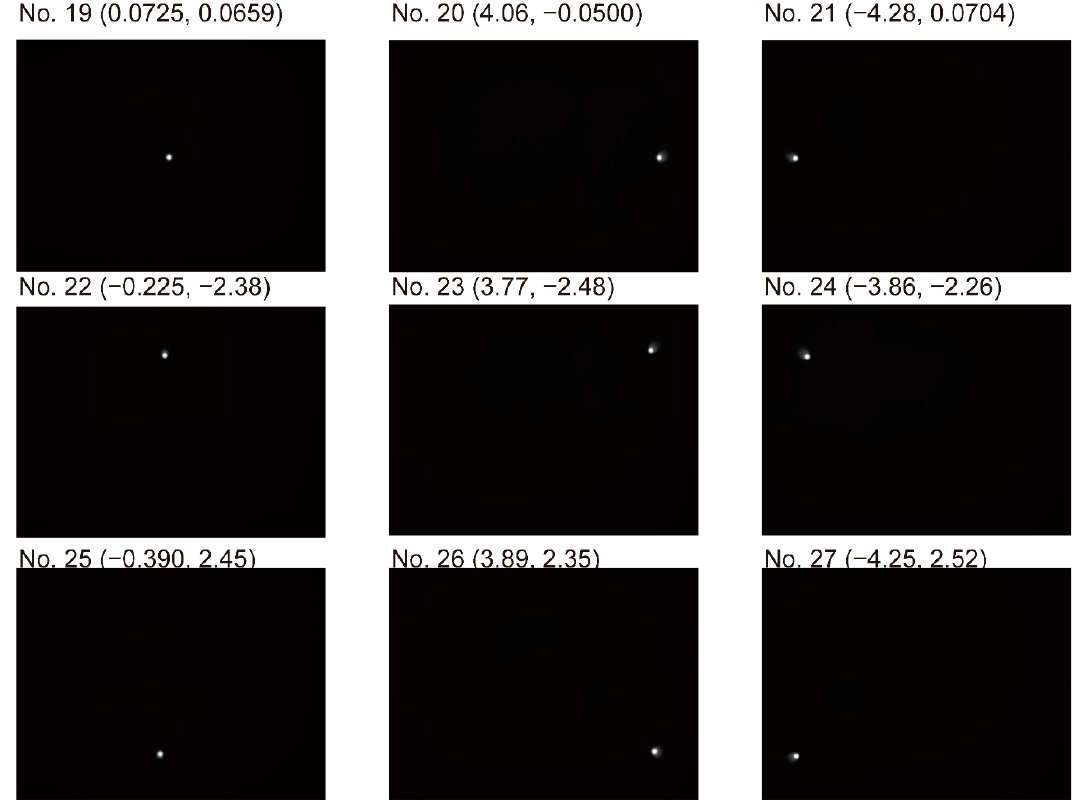
Figure A5. Captured thermal images of the light source at 2 m from the hybrid lens.